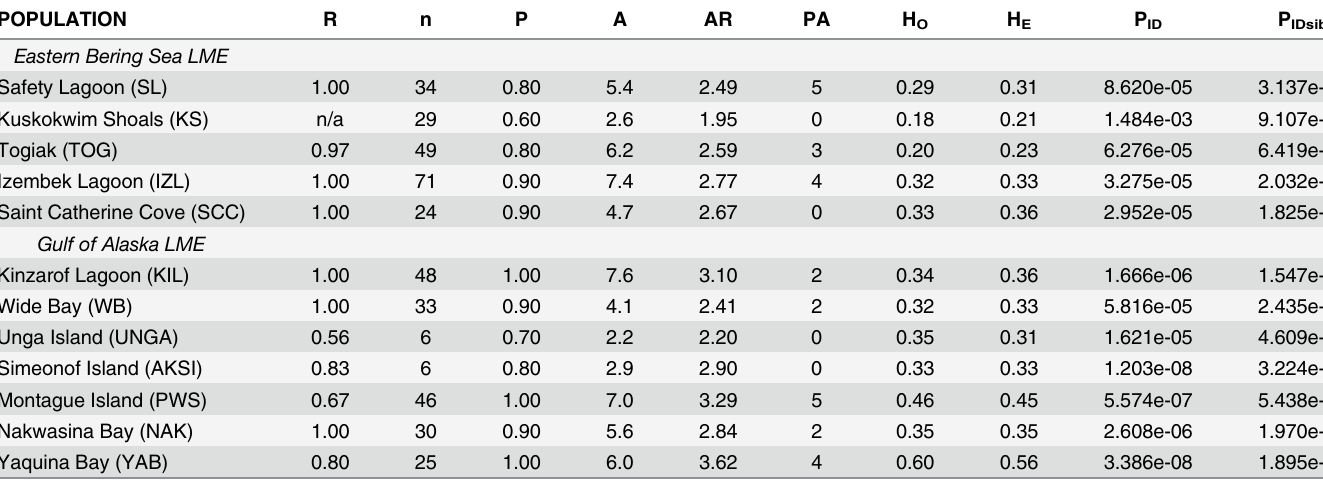
Values are as follows: R = clonal diversity (genotypic richness), n = sample size for analysis (genets only); P = percent polymorphism, A = average